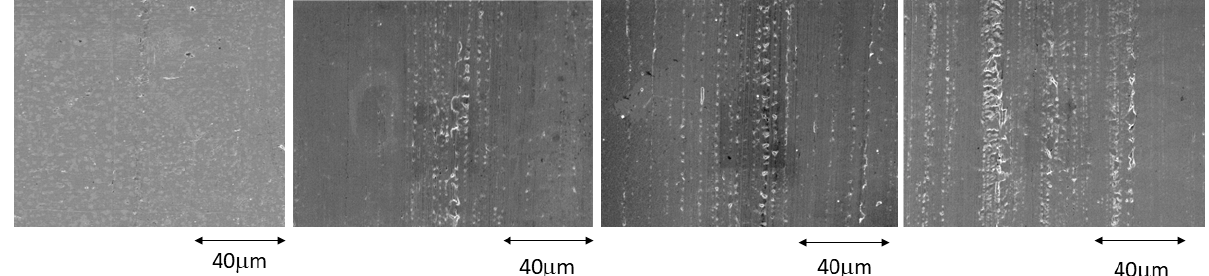
Figure 1. Stainless steel surfaces after 1, 4, 7, and 14 days immersed in a 380 ppm fluoride solution.